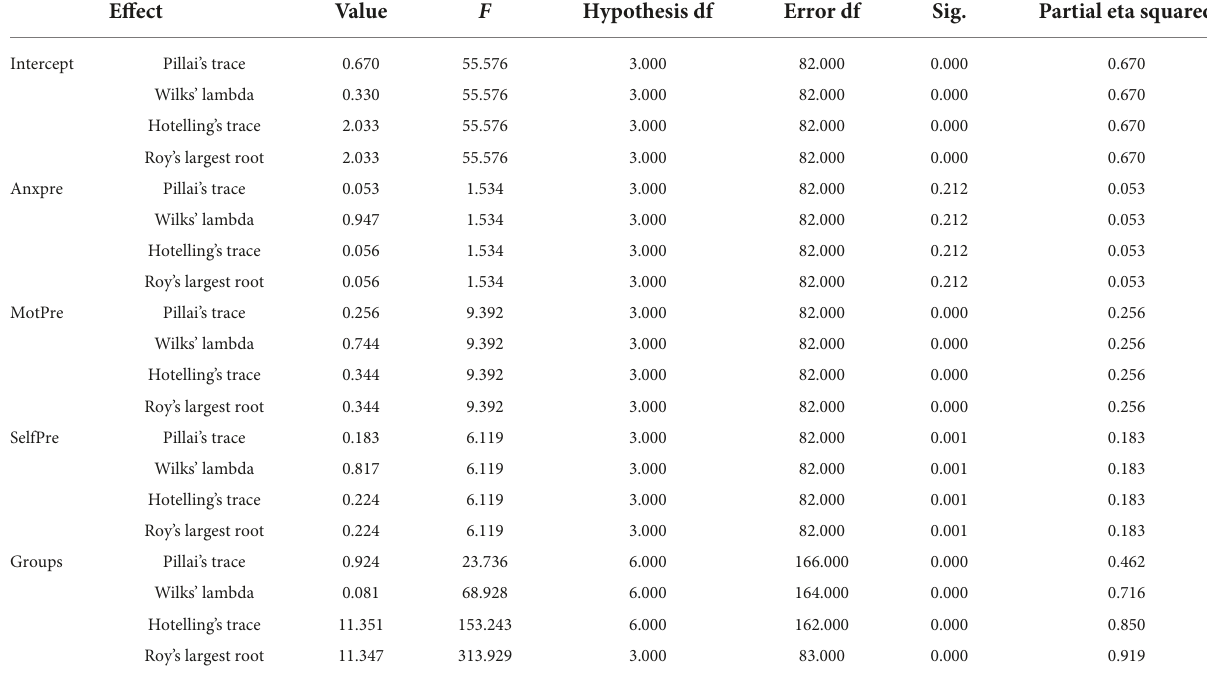
TABLE 2 Results of multivariate tests.